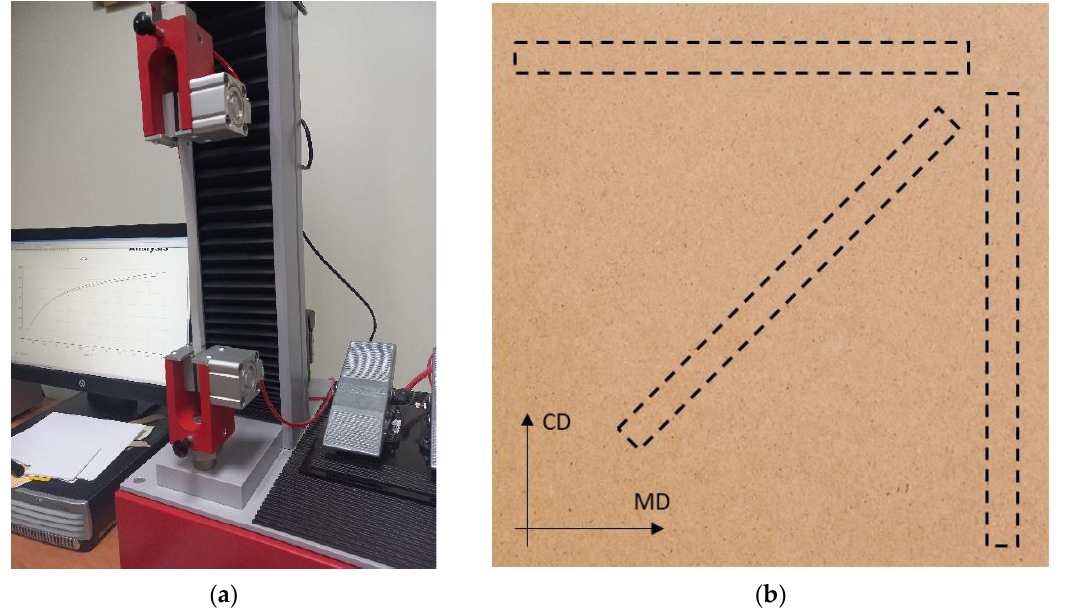
Figure 1. Paper tensile stiffness test: ( a ) laboratory device; ( b ) samples cut in the directions: MD, CD and 45 degrees.